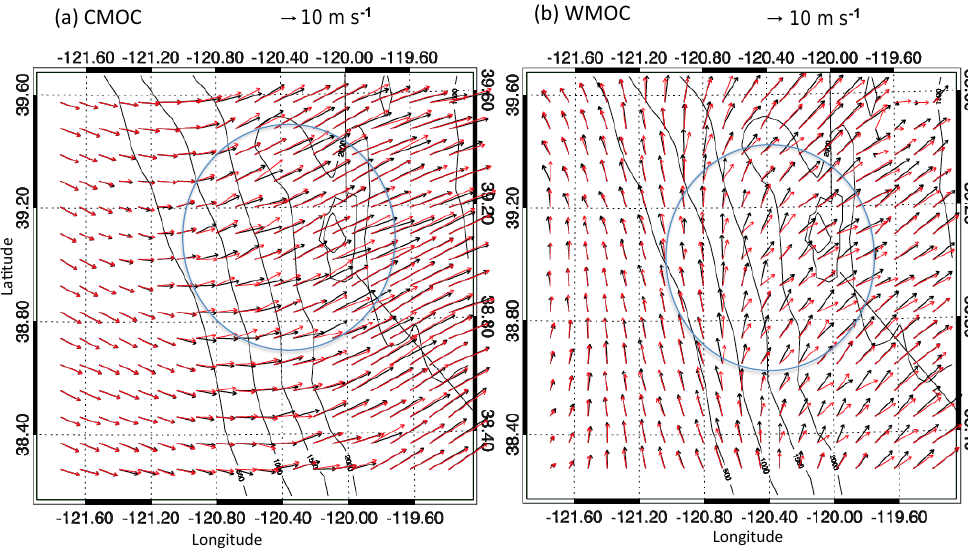
Figure 10. The spatial distribution of wind field at about 1.7km above the ground for (a) the CMOC and (b) the WMOC at 14:00UTC. Red denotes CCN3000 and black denotes CCN30 with IN1. The grey contour lines are the geophysical height in meters. The blue cycle is to mark the area with significant changes in wind (i.e., over the windward slope of the mountain).